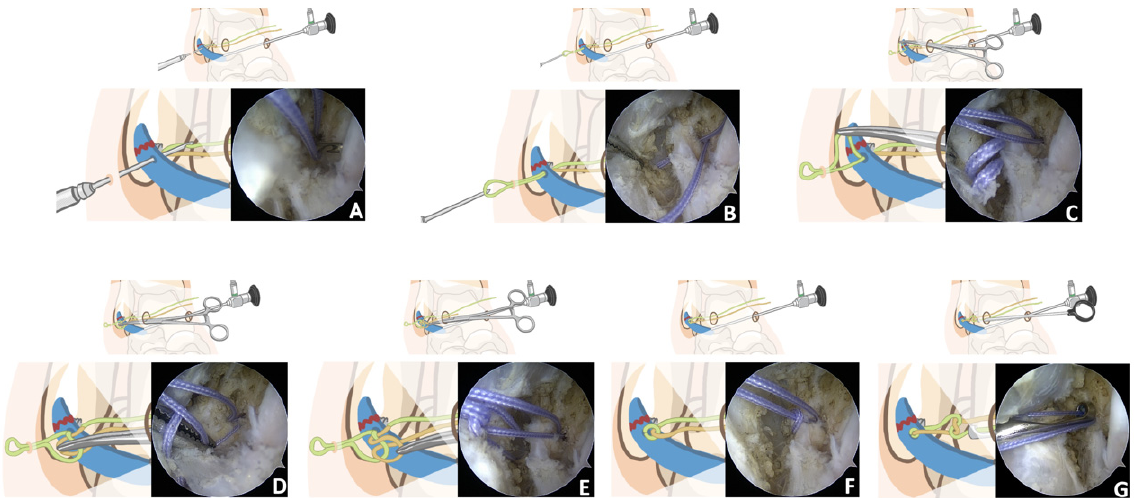
Figure 5. ( A ) The suture is ready for withdrawal once the crochet hook is passed through the ATFL. ( B ) The crochet hook is then used to create a loop wire. ( C ) Mosquito clamp is inserted through AL portal, and the loop wire is clamped out. ( D ) Grasping the contralateral suture, mosquito clamp passes through the loop wire. ( E ) Clamping out the contralateral suture. ( F ) After tightening the sutures, the ATFL is pulled towards the point of attachment. ( G ) Knot pushers are used to fix the ligament in place.